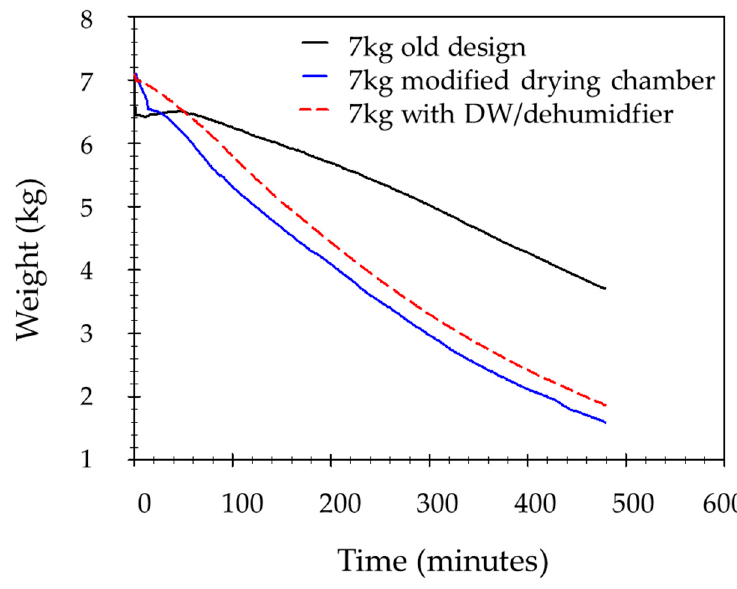
Figure 12. Weight reduction for the maximum test load.